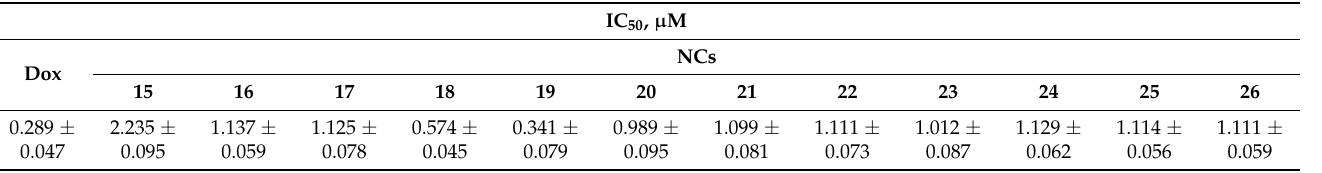
Table 2. IC 50 values of Dox and NCs 15 – 26 for HEK-293 cells after incubation for 48 h (MTT assay). Data are presented as M ± SD.